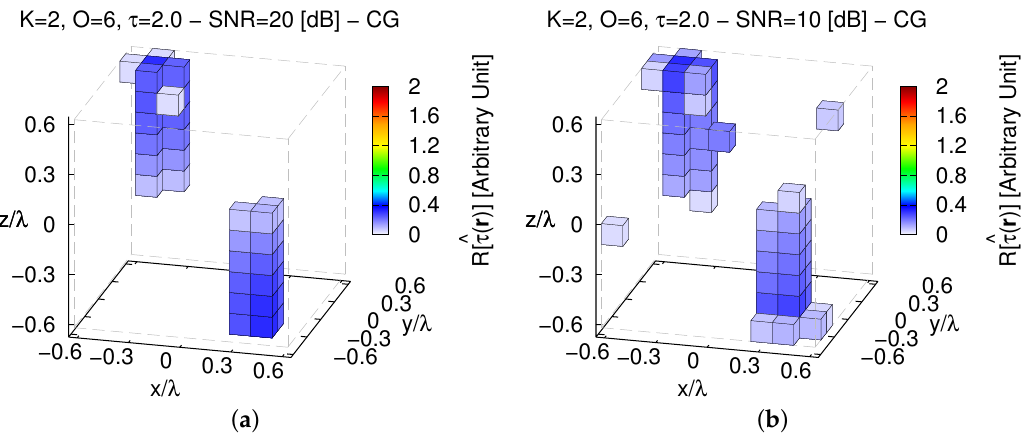
Figure 17. Comparative Assessment ( K = 2, O = 6, τ = 2.0)— CG reconstructions when processing noisy data characterized by ( a ) SNR = 20 [dB] ( (cid:98) τ CG max = 0.33) and ( b ) SNR = 10 [dB] ( (cid:98) τ CG max = 0.36).